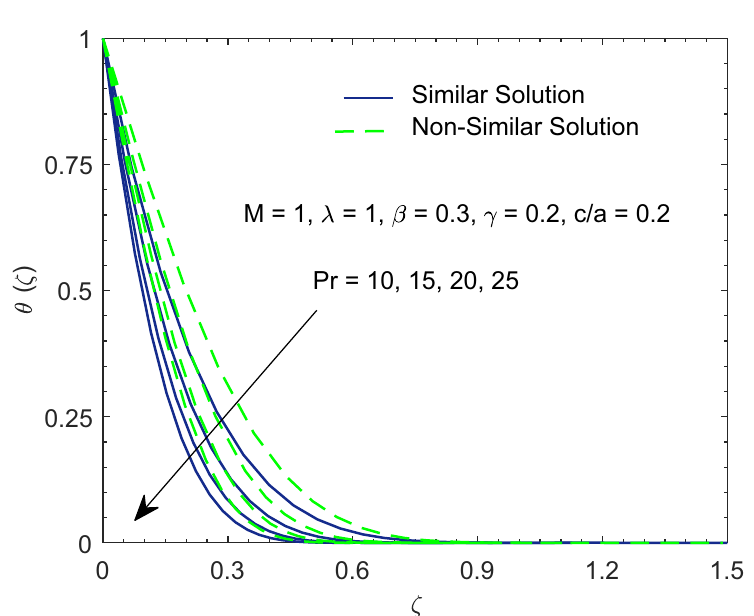
Fig 14. Profiles of θ for various values of Prandtl number Pr in both nonsimilar and Similar